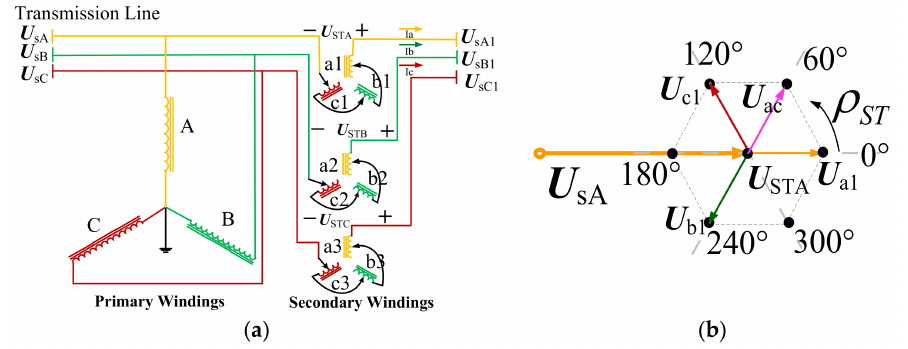
Figure 1. “Sen” transformer (ST) configuration and output voltage. ( a ) ST configuration; ( b ) Output voltage phasor U STA